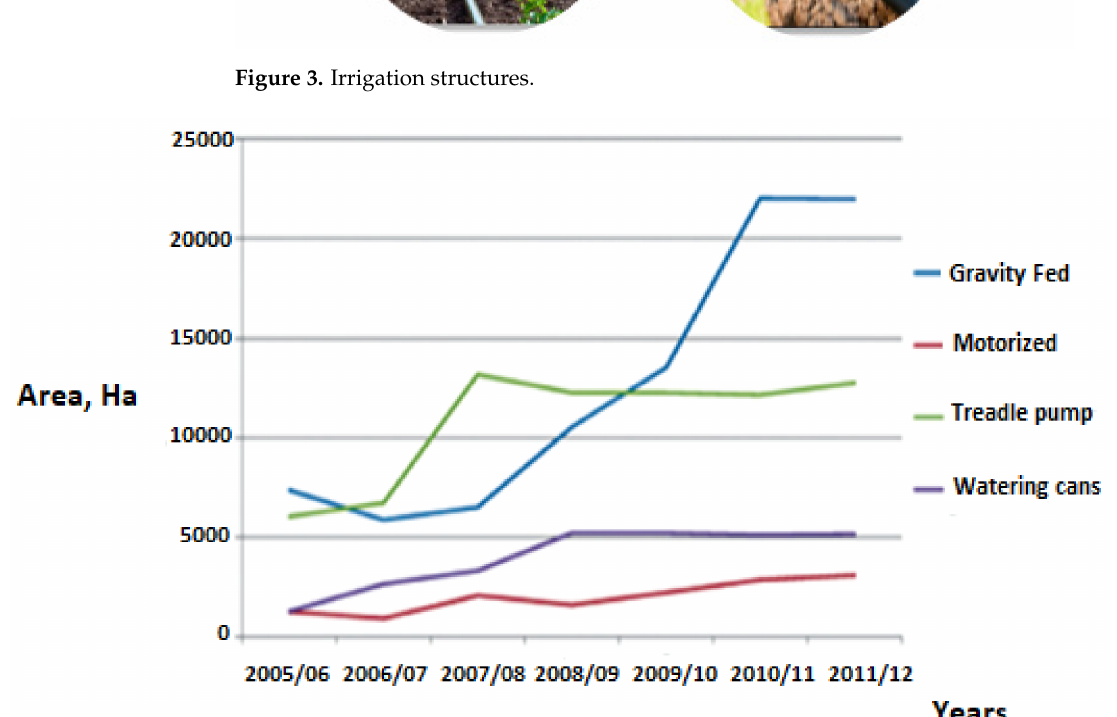
Figure 3. Irrigation structures.